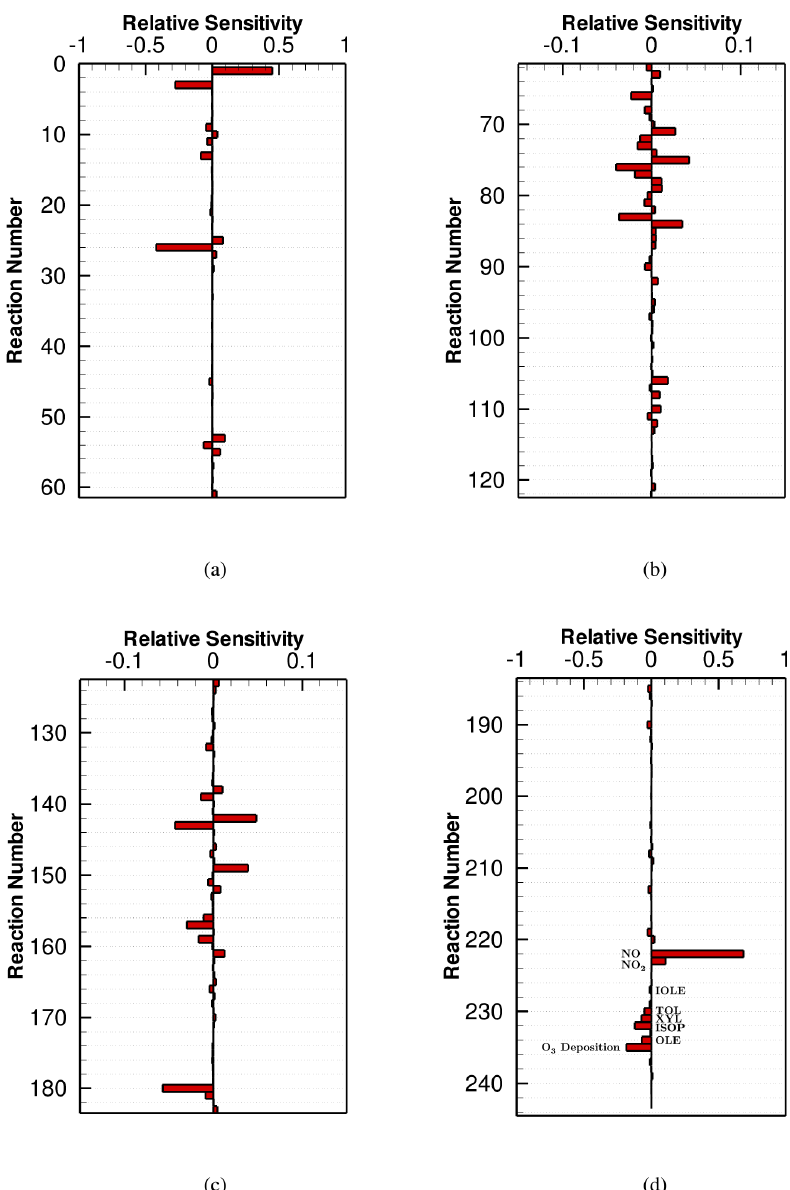
Figure 6. Averaged ozone sensitivity to the CB6r3 mechanism over the seventh day, when the surface emission is strong. All the values of the sensitivities shown in this figure can be found in Table